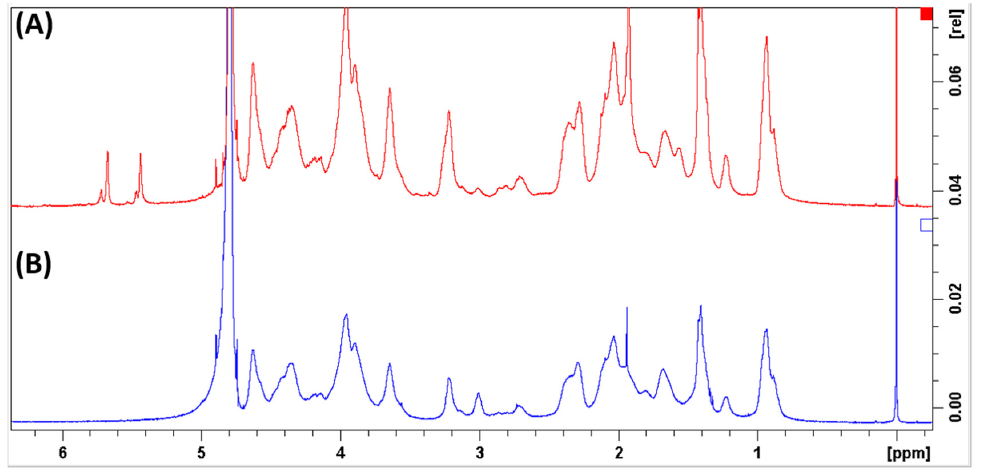
Figure 3. 1H-NMR spectra of ( A ) GelMA, compared with ( B ) porcine gelatine in 1 mL of D2O containing 0.05% ( w/v ) TMSP.